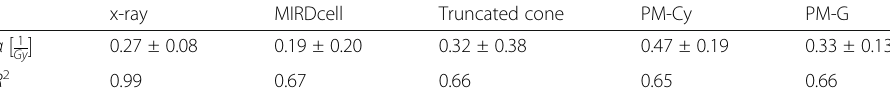
Table 6 The LQ-model parameter α calculated for the x-ray irradiation and the 4 modeling assumptions adopted for the 177 Lu-DOTATATE exposure (with α / β > 100 Gy): MIRDcell, truncated cone, and PM assuming the internalized source either in cytoplasm (PM-Cy) or Golgi